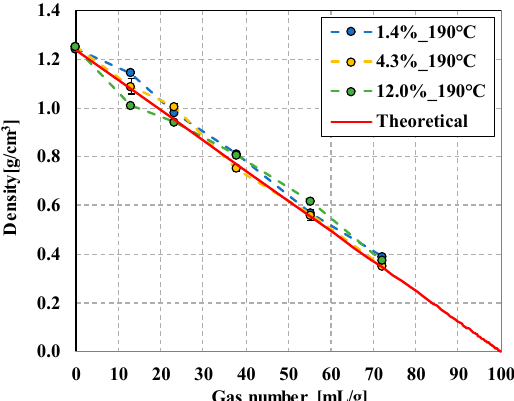
Figure 7. The density of samples prepared at 190 °C as a function of the gas number (theoretically calculated density is shown with a red line).